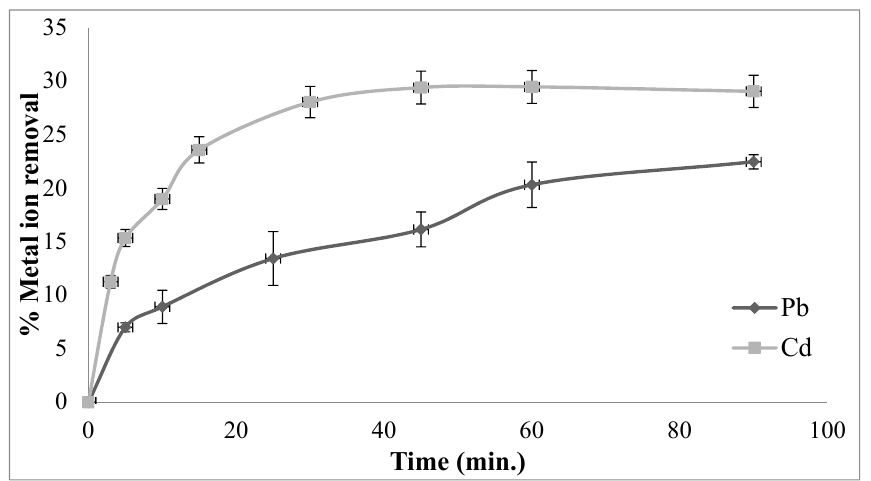
Figure 4. Effect of contact time on metal ion removal (mean ± RSD) (50 mL, 50 ppm) using phragmites powdered biomass (0.1 g, 0.212–0.5 mm) (120 rpm, pH 4, 25 °C). Each measurement has been done in triplicate.